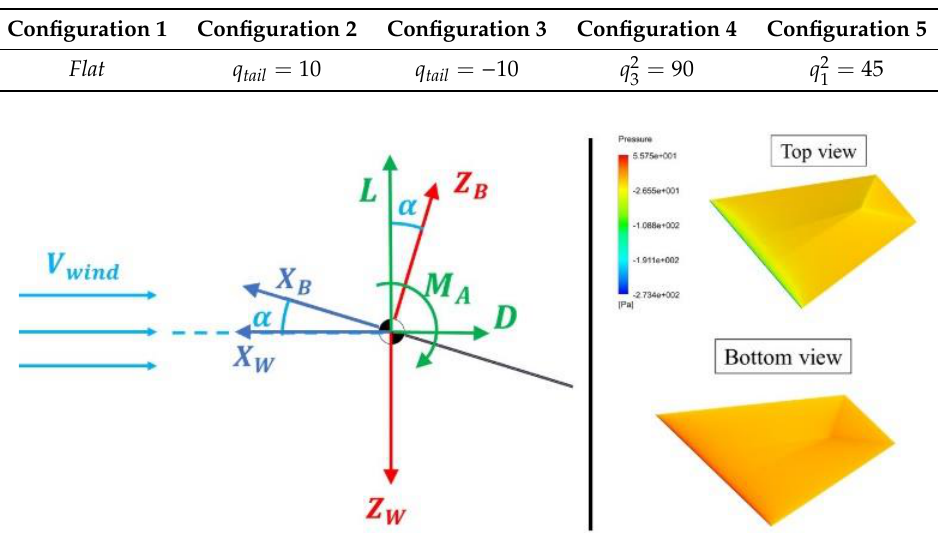
Table 4. Kinematic configurations for each case of study: Configuration 1 serves as a reference; Configs. 2 and 3 a ff ect longitudinal maneuvers; Configs. 4 and 5 a ff ect lateral maneuvers.